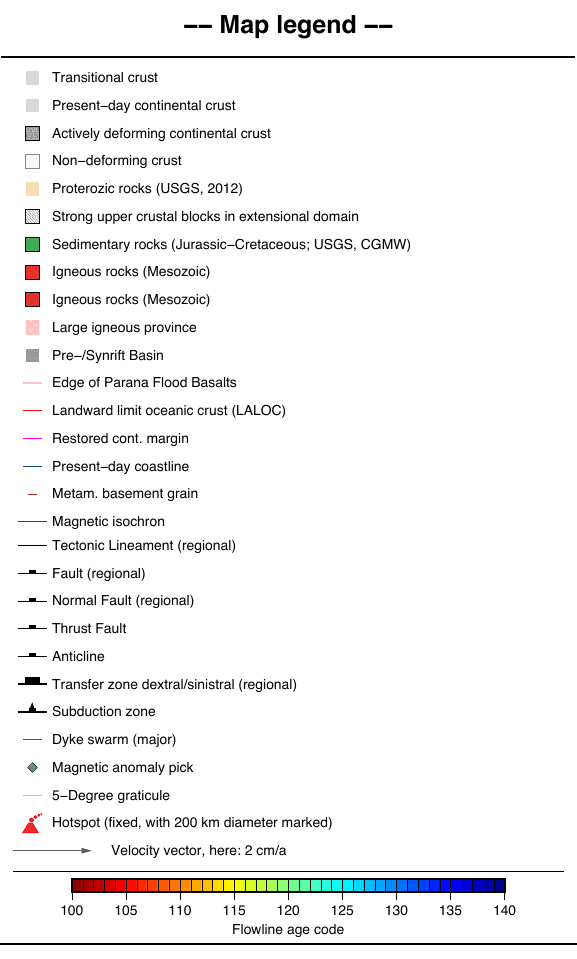
Fig. 22. Map legend for Figs.